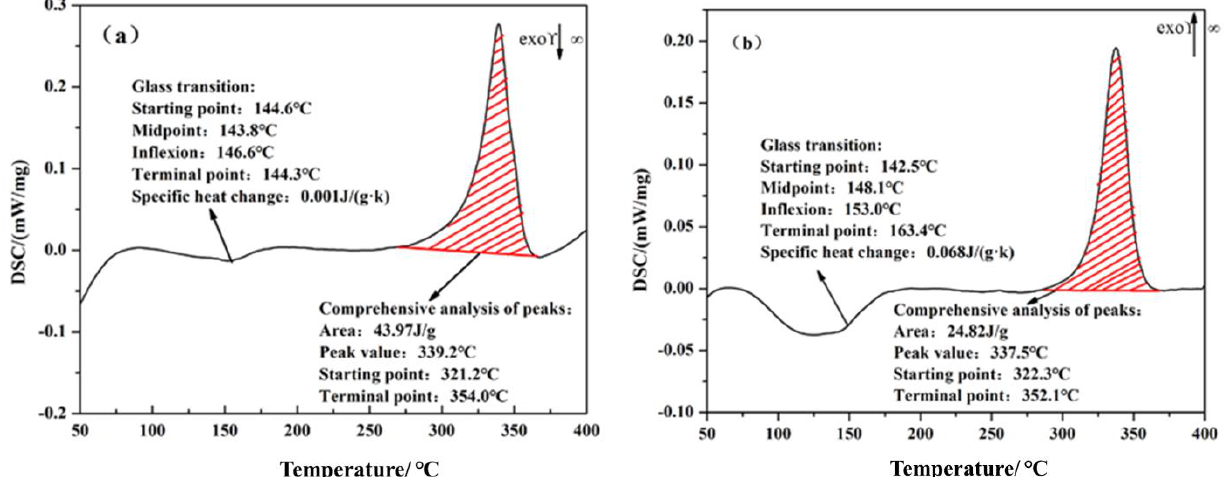
Figure 10. ATR FT-IR spectroscopy graphs of PEEK: ( a ) the infrared spectrum of the fingerprint region of coated PEEK; ( b ) the comparison of coated and uncoated PEEK in the infrared spectrum.